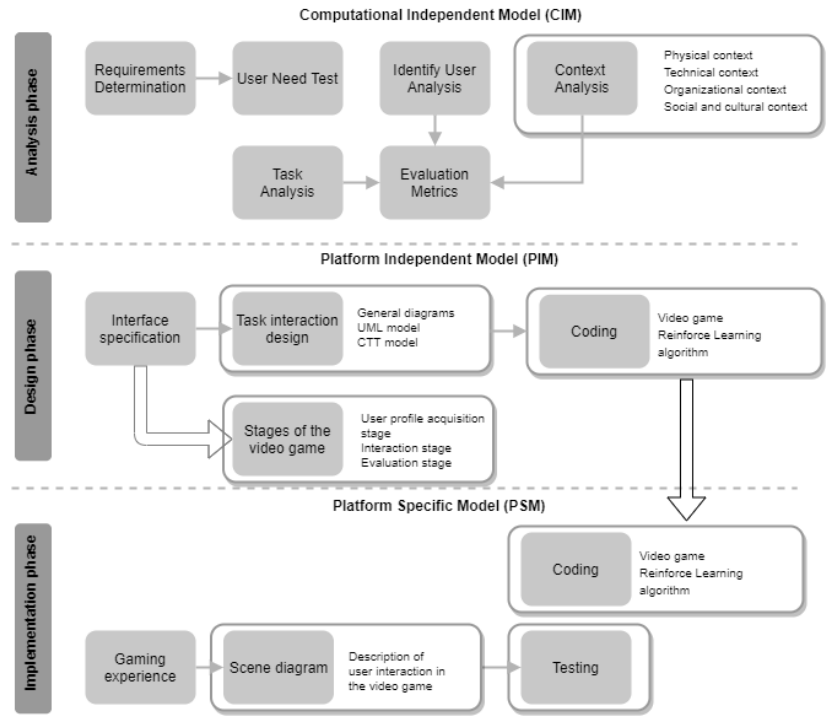
Figure 5. Model-driven approach of virtual interactive environments for enhanced user